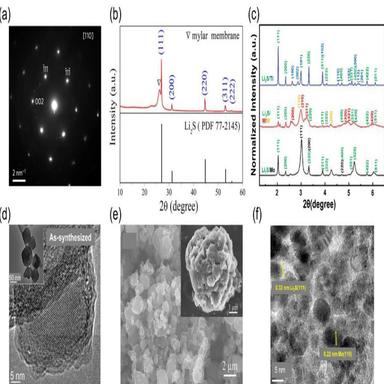
(a) SAED showing single-crystalline Li2S via the reaction between Li and CS2 gas. (b) XRD pattern of the as obtained Li2S@C nanocomposite via the reaction between Li and CS2 liquid . (c) XRD patterns of the as-synthesized Li2S/Ti, Li2S/W, and Li2S/Mo nanocomposites. (d) TEM image of as-synthesized Li2S@graphene capsules via the reaction between Li and CS2 gas. (e) SEM image of nanosized Li2S particles via the reaction between Li and CS2 liquid